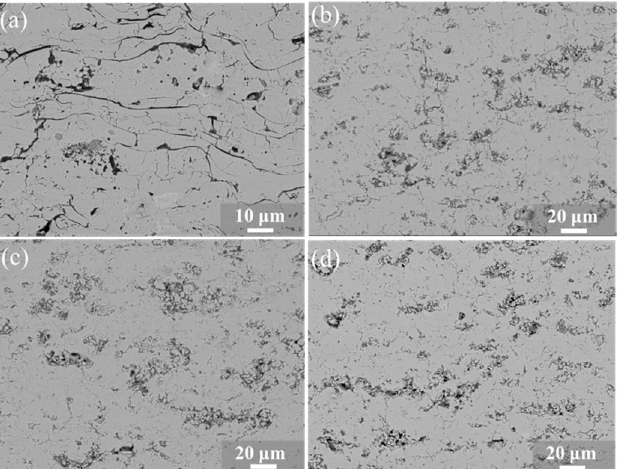
Figure 12. The microstructure of the spraying state of the conventional TBC and EMAP TBCs prepared by different spraying parameters: ( a ) conventional TBC, ( b ) EMAP TBC (d = 35 mm, 12 g/min + 16 g/min), ( c ) EMAP TBC (d = 40 mm, 12 g/min + 16 g/min), and ( d ) EMAP TBC (d = 35 mm, 16 g/min + 16 g/min).